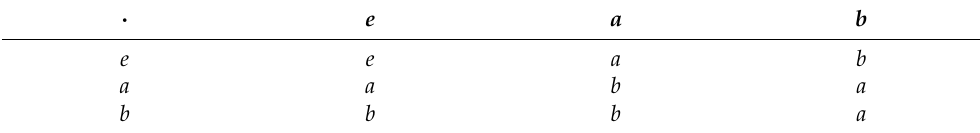
Table 6. The Cayley table of the groupoid X .